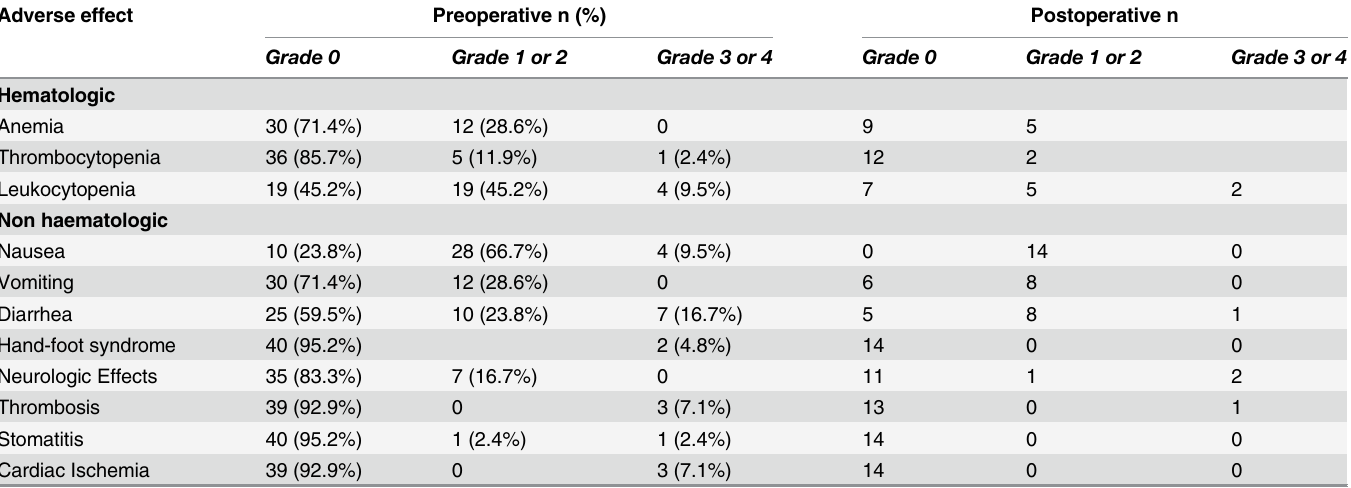
Table 2. Chemotherapy related adverse effects during preoperative and postoperative treatment